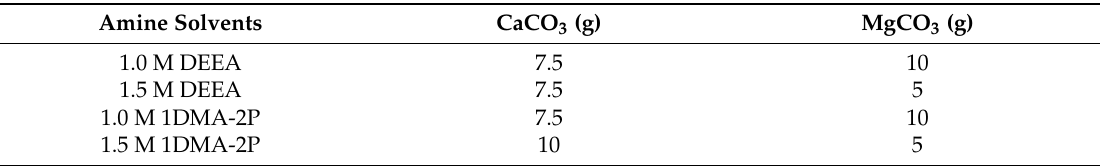
Table 2. The optimized mass of CaCO 3 and MgCO 3 for different amine solvents at 293 K and 1 atm. Amine Solvents